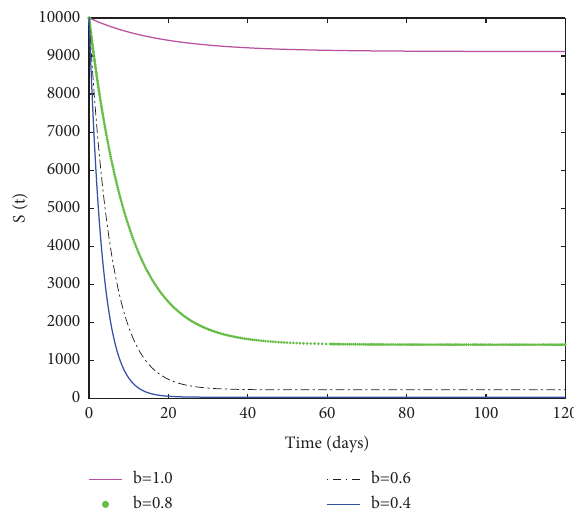
Figure 2: Behaviour of the susceptible individuals at diferent values of b